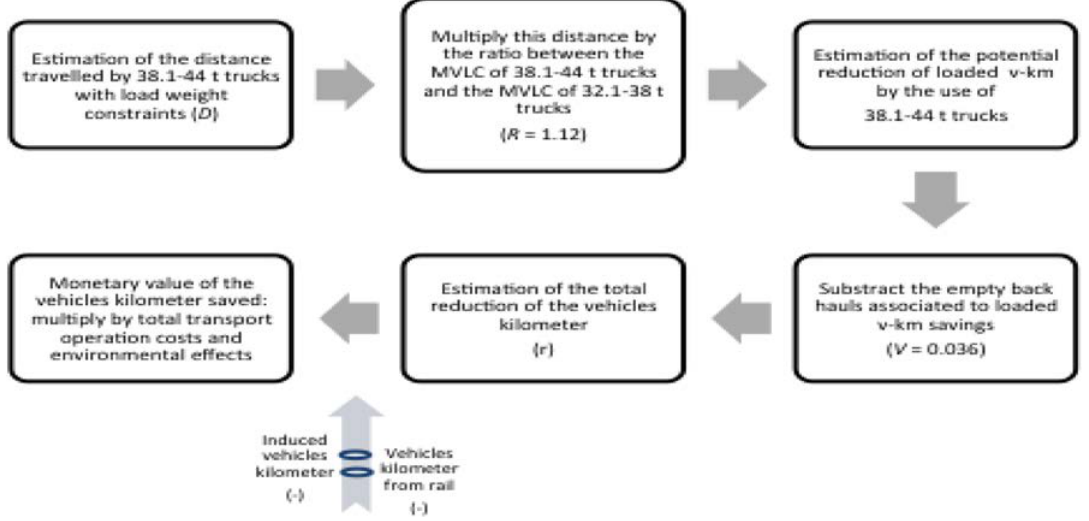
Figure 2. Analytical model used to estimate the benefits of increasing the maximum permissible gross vehicle weight (GVW) of the trucks. Note: MVLC is the maximum loading vehicle capacity (t). Source: McKinnon, 2005 and this